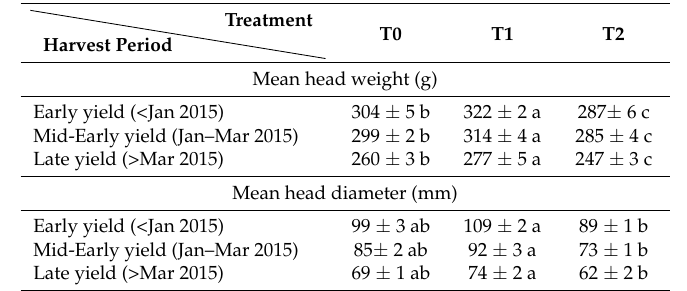
Table 3. Mean weight (g) and mean diameter (mm) of heads per treatment according to the cutting type used for the artichoke vegetative propagation.